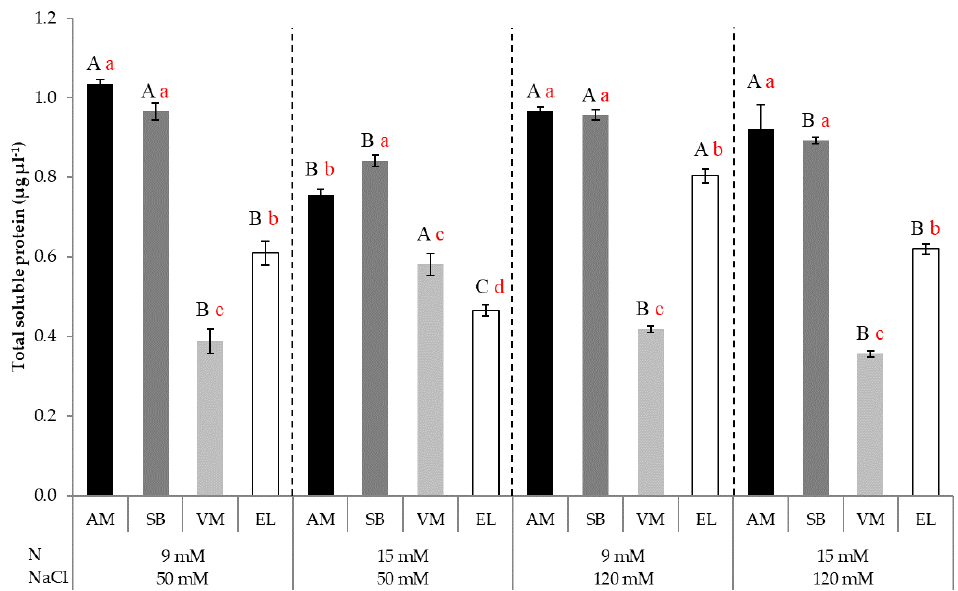
Figure 4. Total soluble protein in Arthrocnemum macrostachyum (AM), Salicornia brachiata (SB), and Sarcocornia fruticosa ecotypes (EL and VM). LN under different combinations of N (9 and 15 mM) and NaCl (50 and 120 mM). Means plus standard errors ( ± SE) are shown. Different uppercase letters show significant differences between treatments of one ecotype (same color bars), and different lowercase red letters show significant differences between ecotypes within the same treatment (Tukey’s HSD, p ≤ 0.05, n = 7).